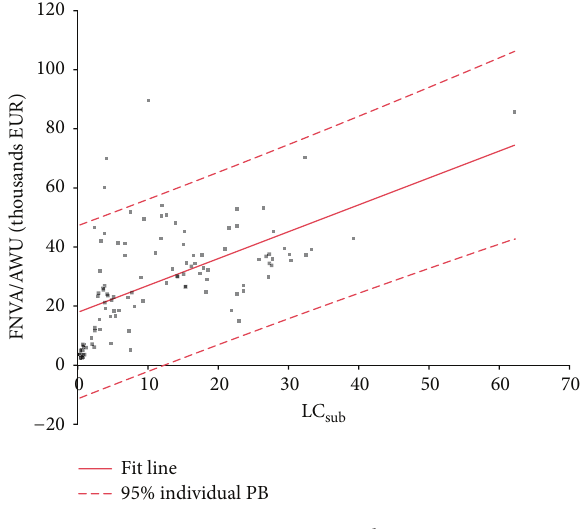
the 4th/bottom quartile of LC Spain, Portugal, Malta, Poland, Latvia, Lithuania, Bulgaria, and